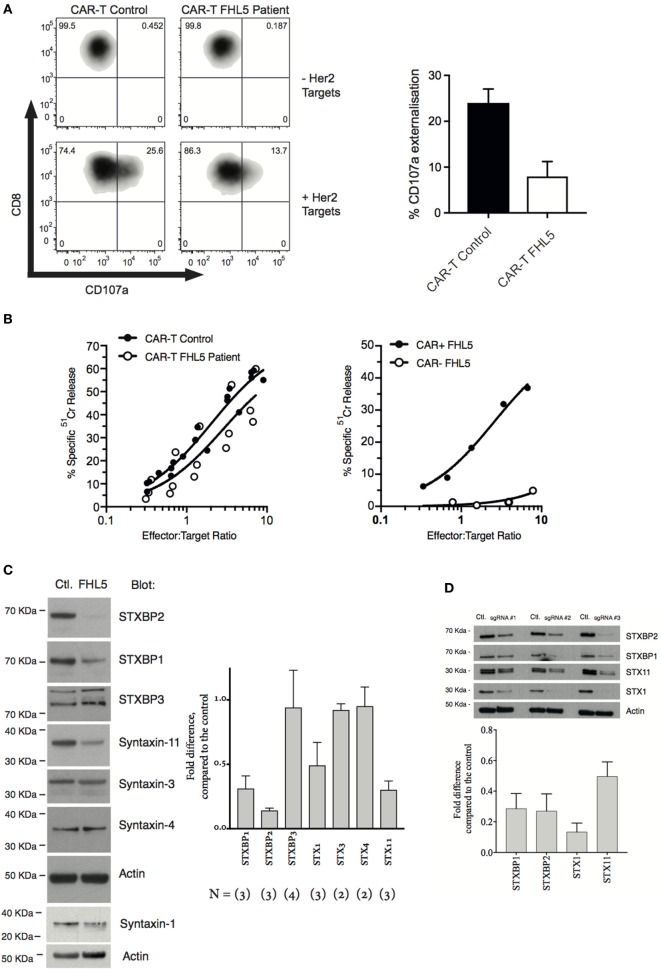
STXBP2 mutations inhibit T-cell degranulation and perturb the expression of the STXBP1 isoform. (A) Peripheral blood mononuclear cells (PBMCs) were isolated from a healthy donor control (CAR-T Control) or an FHL5 patient (CAR-T FHL5 Patient) and incubated with 30 ng/mL of anti-CD3 antibody and 600 U/mL of IL-2 for 3 days. Cells were transduced with virus expressing a CAR specific for the Her2 antigen. CAR transduced PBMCs were incubated for 3 h in the absence (−Her2 Targets) or presence (+Her2 Targets) of MDA-MB-231 target cells overexpressing human Her2. CD8+CAR− T-cell degranulation was assessed by measurement of CD107a surface labeling in the CD8+ cell populations. The right panel shows the % of cells labeled for CD107a after incubation with Her2 targets. Data represent the mean ± SEM (n = 3 experiments). (B) CAR-T-expressing Control and FHL5 cells were incubated with 51Cr-labeled MDA-MB-231 Her2 expressing target cells for 4 h at the indicated effector to target cell ratios (normalized for the % of CD8+ T cells). CAR-T cytotoxicity was determined by the release of 51Cr from target cells. Data are representative of two independent experiments. The right panel shows the cytotoxicity of FHL5 CD8+ T cells in the absence (CAR−) and presence (CAR+) of CAR expression. Data are representative of two independent experiments. (C) PBMCs were isolated from a healthy donor control (Control) or an FHL5 patient and incubated with 30 ng/mL of anti-CD3 antibody and 600 U/mL of IL-2 for 3 days. CD3+CD8+ T cells were isolated by flow cytometry and whole cell lysates were blotted for STXBP1, STXBP2, STXBP3, STX1, STX3, STX4, STX11, and actin (loading control). Molecular weight standards (KDa) are indicated. The right panel shows the protein expression (% of Control) for each of the proteins in the FHL5 samples after each blot was normalized for actin expression. Data represent the mean ± SD (n = 2–3 experiments). (D) PBMCs were isolated from a healthy donor and incubated with 30 ng/mL of anti-CD3 antibody and 600 U/mL of IL-2 for 3 days. Cells were transduced with virus expressing Cas9 and the sgRNAs #1, #2, and #3. GFP+ Cherry+ and GFP− Cherry− control (Ctl) cells were isolated by flow cytometry and whole cell lysates were blotted for STXBP1, STXBP2, Syntaxin-11, Syntaxin-1, and actin (loading control). Molecular weight standards (KDa) are indicated. The panel below shows the protein expression (% of Control) for each of the proteins after each blot was normalized for actin expression. Data represent the average of three guides ± SEM (n = 3).